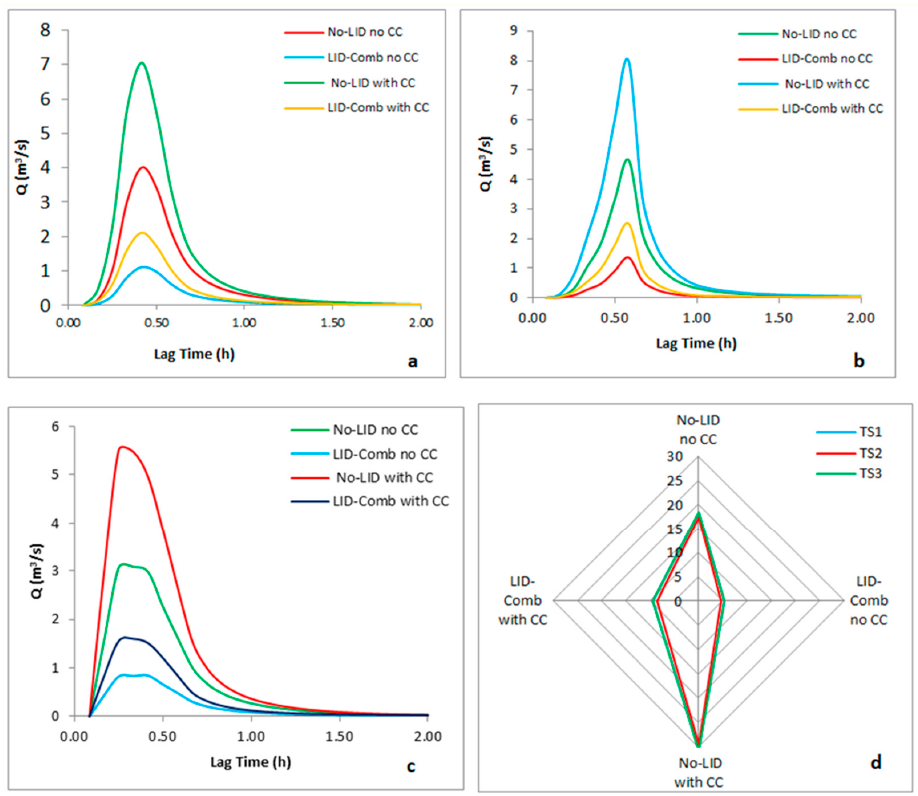
Figure 10. Climate Change and LID Impacts on Peak Runoff Magnitudes of Rainfall Patterns: ( a ) TS1; ( b ) TS2; ( c ) TS3 and ( d ) Runoff Volume.